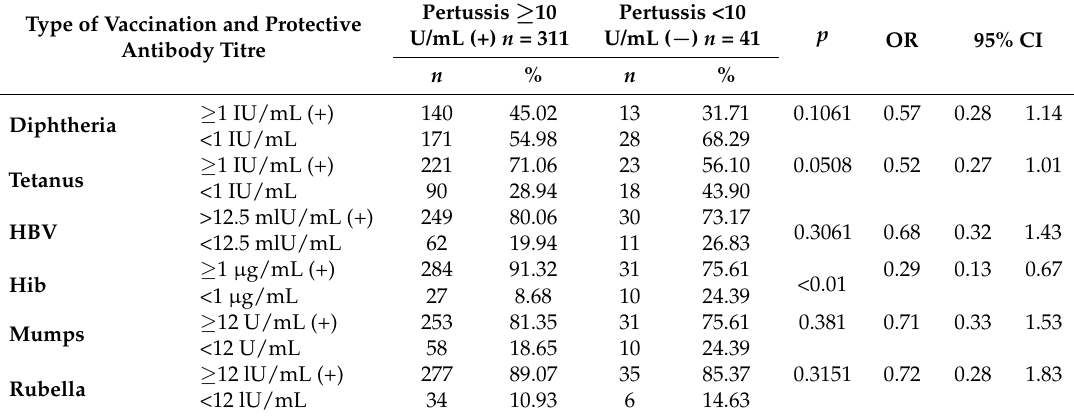
Table 3. Concentration of pertussis antibody and other antibody titres.